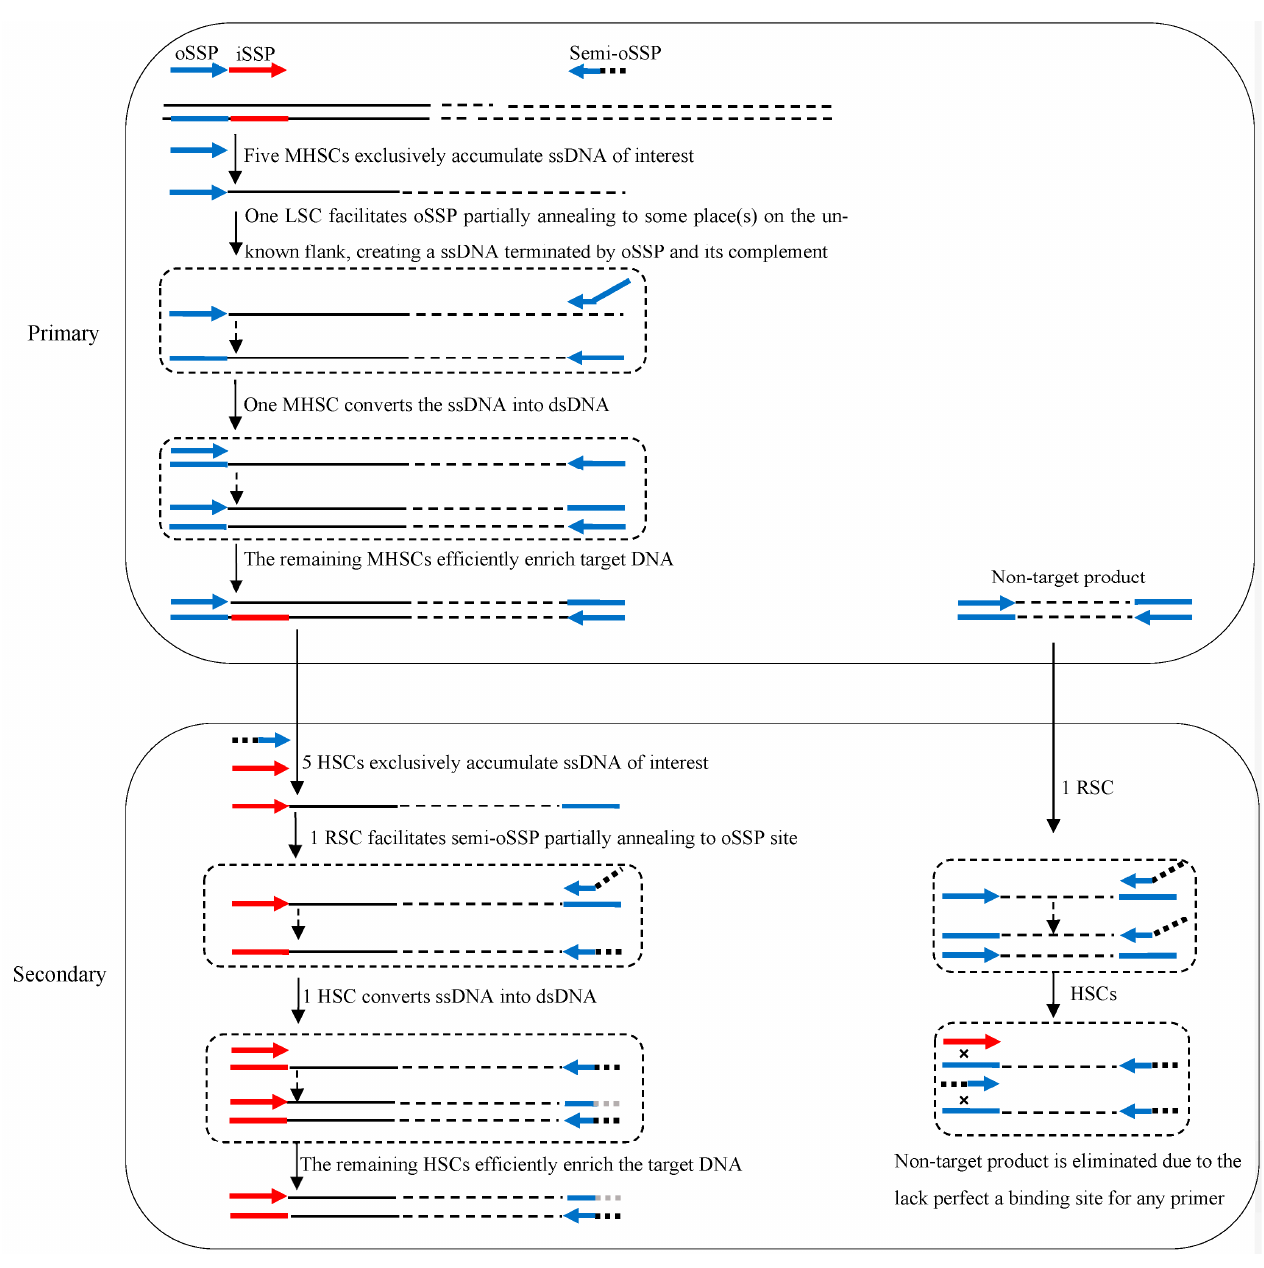
Figure 1. Schematic diagram of semi-site-specific primer PCR. oSSP: outer site-specific primer; semi-oSSP: semi-outer-site-specific primer; iSSP: inner site-specific primer. Thin solid line: known sequence; thin dotted line: unknown sequence; colored thick arrows: primers; colored thick lines: primers’ complements; ssDNA: single-stranded DNA; dsDNA: double-stranded DNA; MHSC: moderate high-stringency cycle; HSC: high-stringency cycle; LSC: low-stringency cycle; RSC: reduced-stringency cycle.